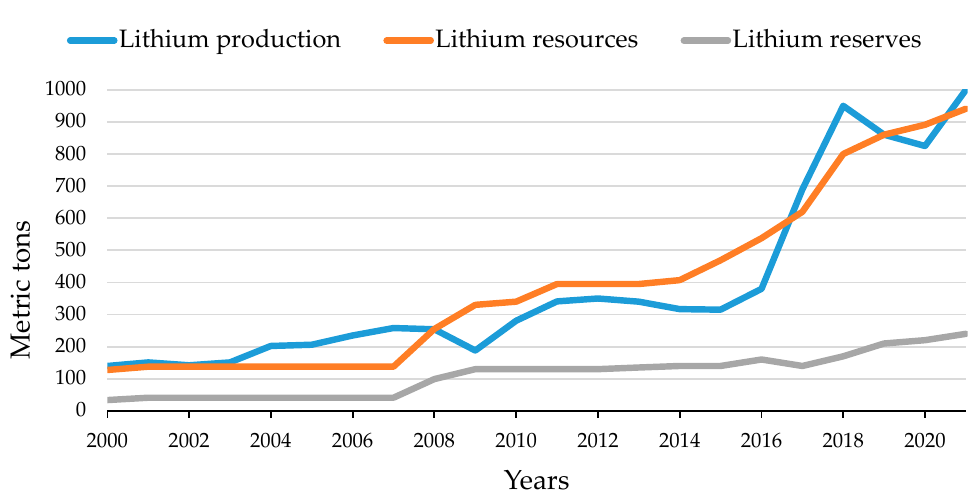
Figure 7. Trends of Lithium production (10 2 ), resources (10 5 ), and reserves (10 5 ) between 1994 and 2021. Table 5. Pearson correlation of mines effect group at a significant level of